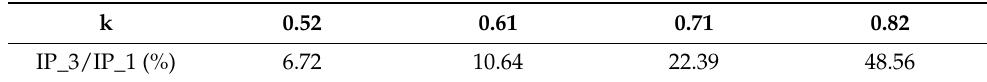
Figure 11. Experiment platform. The influence of the strong coupling condition on system performance was first in- vestigated on a single channel system. When the load resistance is 50 Ω , the inverter out- put voltage and current waveform are shown and compared in Figure 12. The component of the fundamental wave and third harmonic is then calculated and demonstrated in Table 1. As the coupling coefficient increases from 0.52 to 0.82, the inverter current waveform distortion worsens and the component of third harmonic increases from 6.72% to 48.56%, which means the component of harmonic increases as the increase of coupling coefficient, which agrees with the theoretical analysis. ( a )